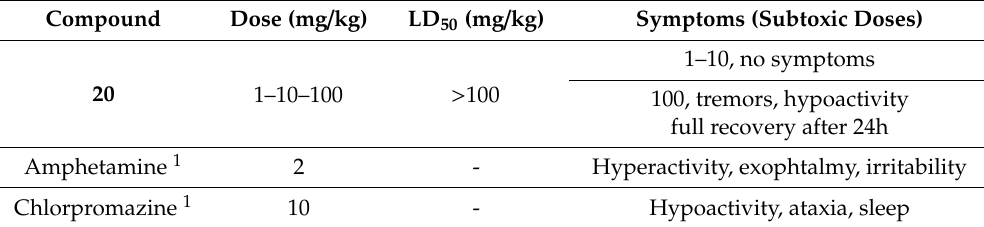
Table 3. Pharmacological and toxicological properties of Table 4. Pharmacological and toxicological properties of 20 .